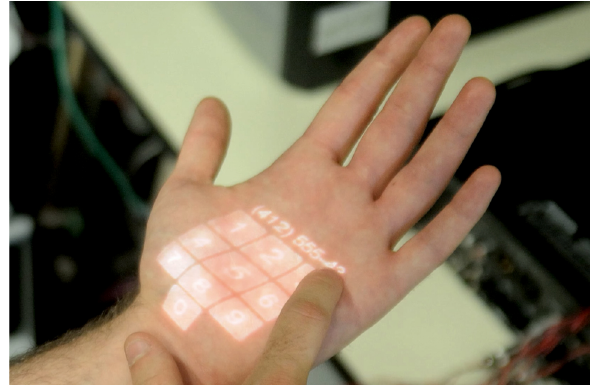
Figure 3 | A virtual keypad is projected onto a user’s palm and allows the user to dial a phone number. Image courtesy of Chris